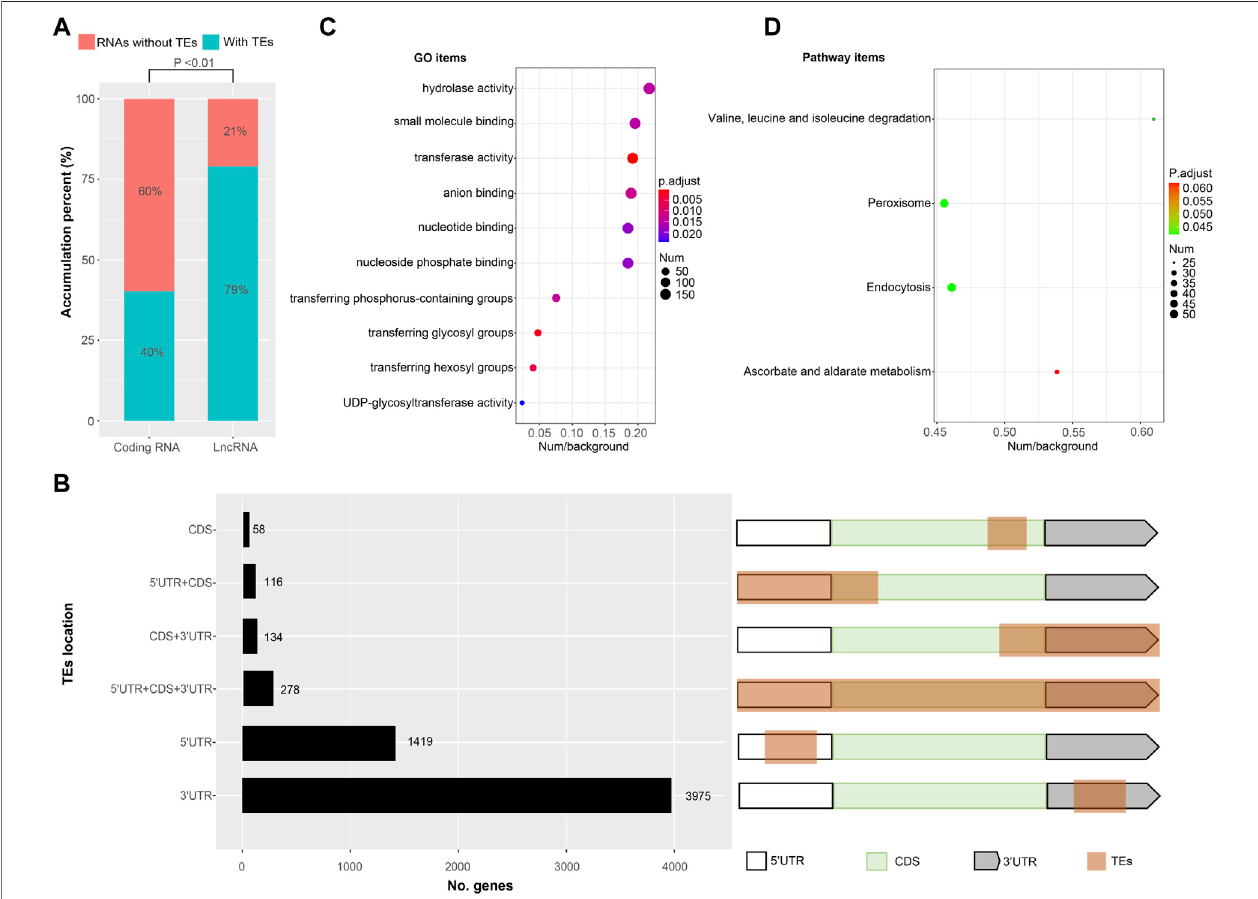
FIGURE 4 | Transcripts with transposable elements (TEs) exonization (A) The proportion of TEs exonization transcripts in protein coding transcripts and lncRNAs, respectively ( B ) The location distribution of TEs derived sequences in protein coding transcripts. White boxes represent 5 ′ UTR, green boxes represent coding DNA sequences (CDS), gray boxes represent 3 ′ UTR and brown box represent TEs derived sequences ( C ) GO enrichment results of TEs exonization transcripts ( D ) KEGG enrichment results of TEs exonization transcripts.